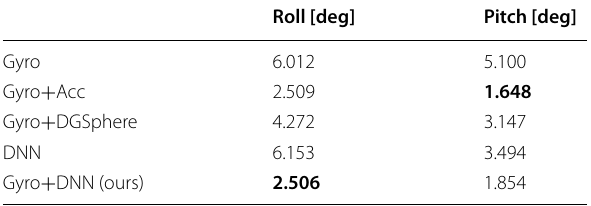
Bold value represents the best result in each experiment/validation